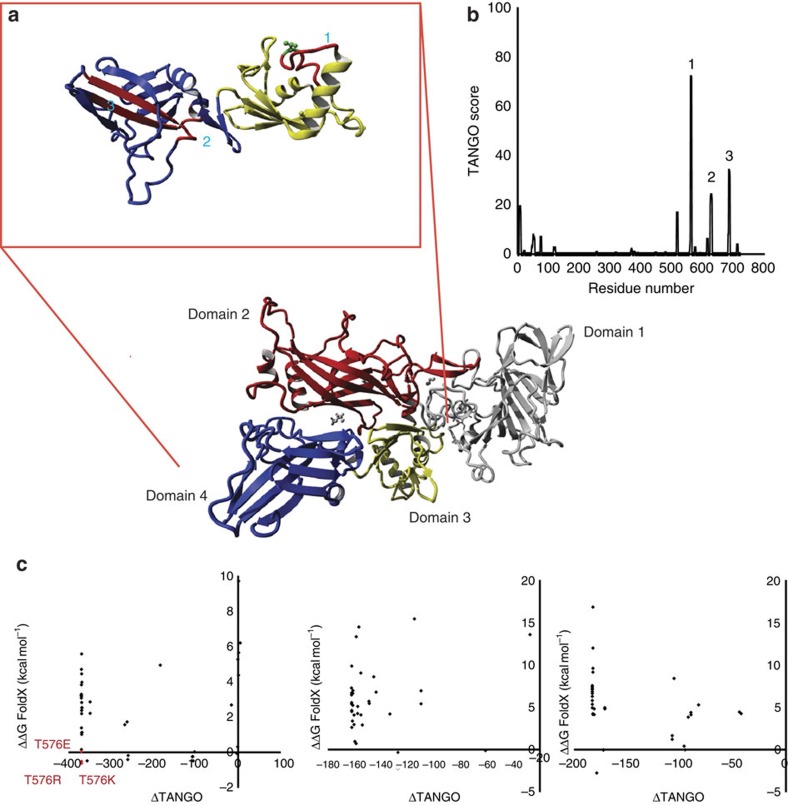
Structure and aggregation propensity of protective antigen (PA) of B. anthracis.(a) Monomeric PA is composed of four structural domains consisting predominantly of anti-parallel β-sheet: D1 is the calcium-binding domain (grey), D2 is the membrane insertion and heptamerization domain (red), D3 is the heptamerization domain (yellow) and D4 is the receptor binding domain (purple). (b) The intrinsic aggregation profile as predicted by TANGO indicated the presence of three main APRs, which are located in domains 3 and 4. The aggregation kinetics were shown to be dominated by the solvent exposed APR1 in the loop region of domain 3 (ref. 33). (c) MASS plots for the three APRs indicated in b. The mutations in APR 1 that we focused on are indicated in red.